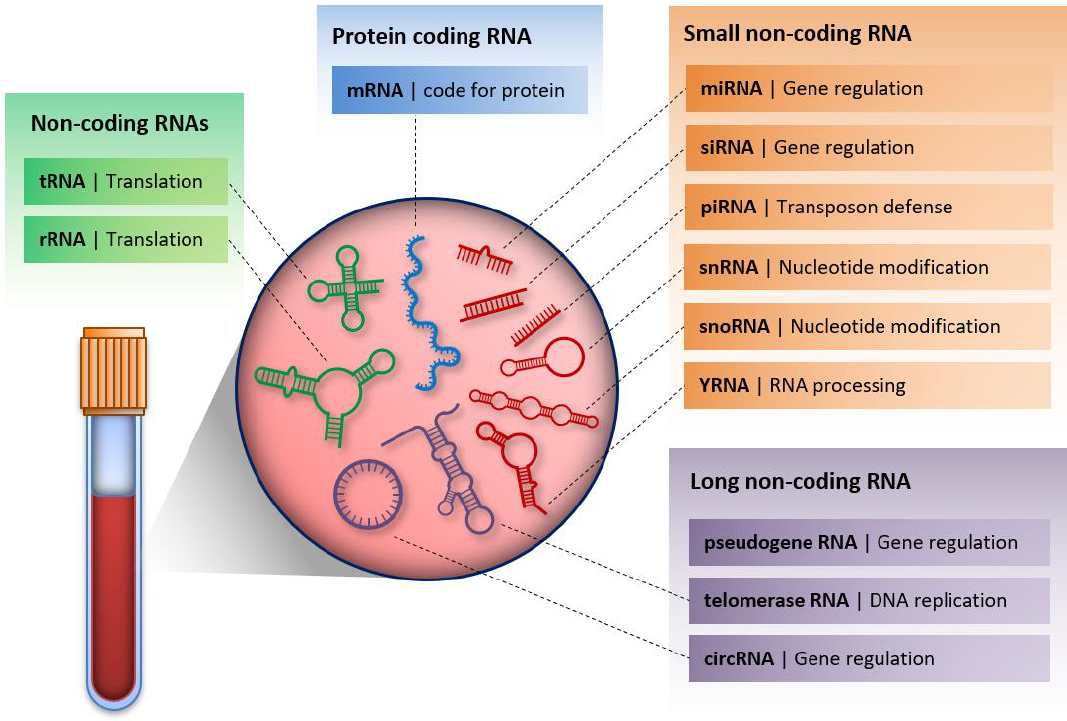
Figure 2. Cell-free RNA molecules in serum/plasma with their biological function.